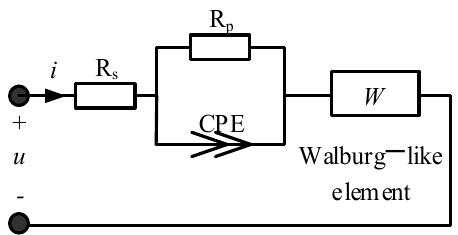
Figure 10. Fractional order model structure.